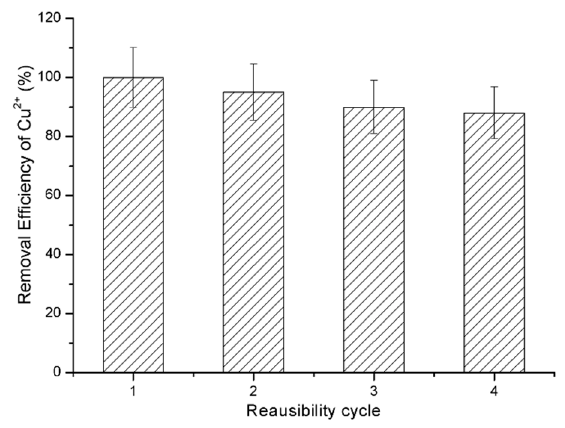
Figure 10. Reusability cycles of MNPs@SiO 2 @GOPTS-bPEI, expressed as adsorption–desorption studies, for copper removal.